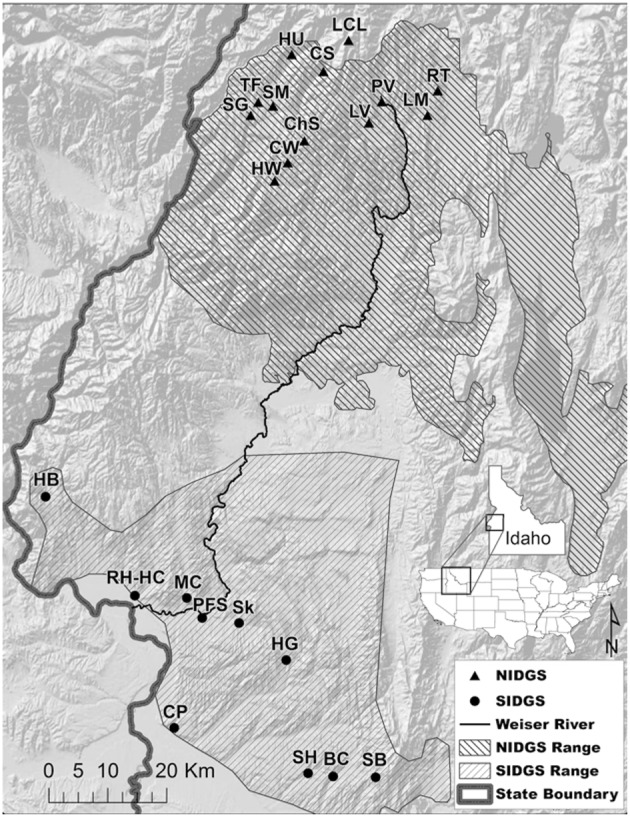
Sampling locations of genetic data for northern Idaho ground squirrel (Urocetillus brunneus; NIDGS) and southern Idaho ground squirrel (U.endemicus; SIDGS). Also shown are the NIDGS probable historic distribution (U.S. Fish and Wildlife Service, 2003) and the current known range for SIDGS (Idaho Game and Fish Department). Individuals were sampled from 2002 to 2006 (Hoisington-Lopez et al., 2012). Background hillshade map was produced from the National Elevation Dataset (http://ned.usgs.gov). Full site names and sample sizes can be found in Table S1.